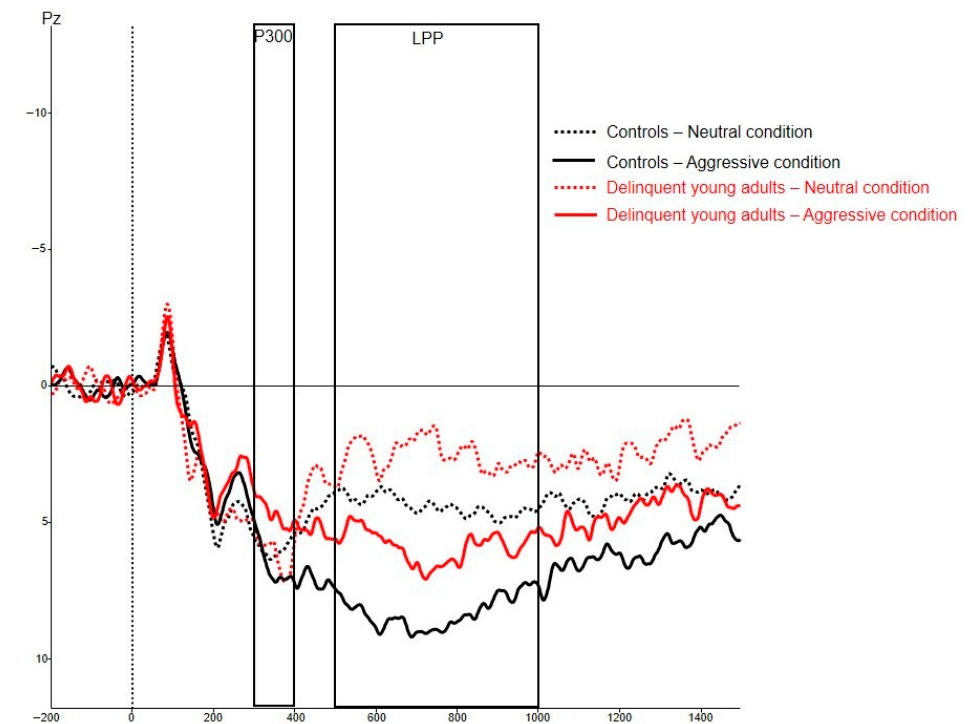
Figure 2. Grand average ERPs at Pz.